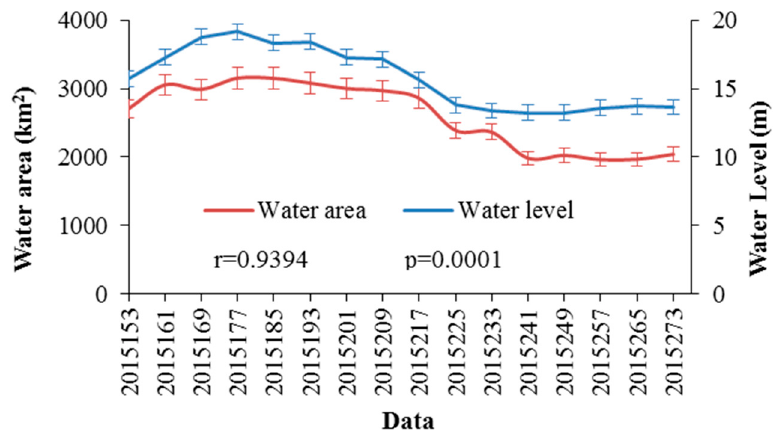
Figure 16. Variation of water area of Poyang Lake and water level of Hukou hydrological station during the wet period in 2015.